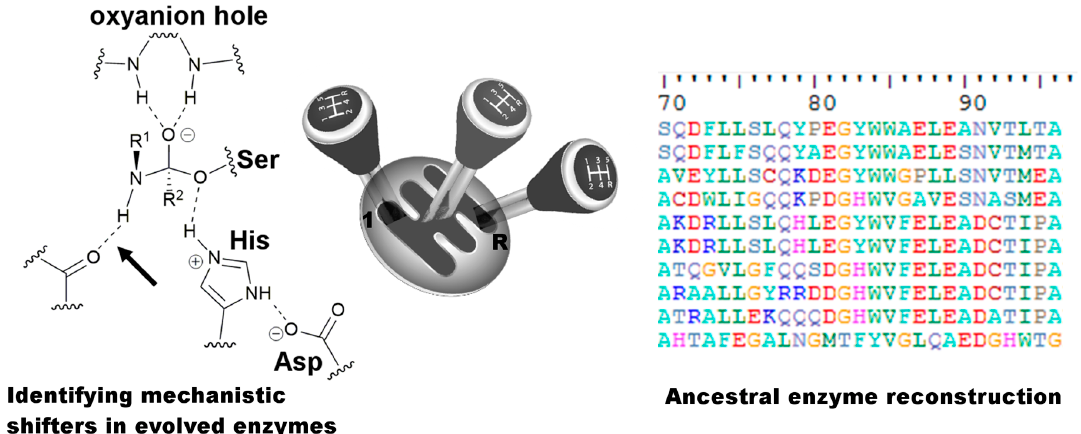
Figure 1. Two different strategies to discover novel enzyme scaffolds with enhanced promiscuous activity. Left: Boosting promiscuous activity by focusing on the in silico discovery [23,24] and engineering [34] of key mechanistic structural elements in modern enzymes is represented by the forward gear. This is exemplified by focusing on a hydrogen bond acceptor (arrow) that could act as a shifter for enhanced amidase over esterase activity by facilitating nitrogen inversion (structure shown), a key step in amide bond hydrolysis [26]. We have shown that the previously unacknowledged key hydrogen bond donated by the reacting NH ‐ group facilitates nitrogen inversion, the overall rate limiting step of enzyme catalyzed amide bond hydrolysis [26,27,35]. As the specific orientation of the single lone pair of the reacting nitrogen is governed by stereoelectronic effects [36], nitrogen inversion is required during biocatalysis for the generation of a productive second tetrahedral intermediate. In contrast, for ester hydrolysis the additional lone pair sitting on the ester oxygen can readily accept a proton from the catalytic base with only subtle rearrangements. The catalytic triad and oxyanion hole are labeled for a serine hydrolase catalytic machinery. Right: A fundamentally different approach attempts to boost promiscuous activity by reversing evolution through bioinformatic-guided resurrection of ancient and presumably less specific enzymes based on protein sequences that are present